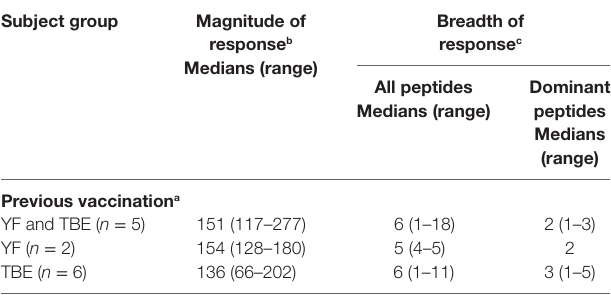
TaBle 4 | Zika virus CD4 T cell responses in patients with previous tick-borne encephalitis (TBE) or yellow fever (YF)